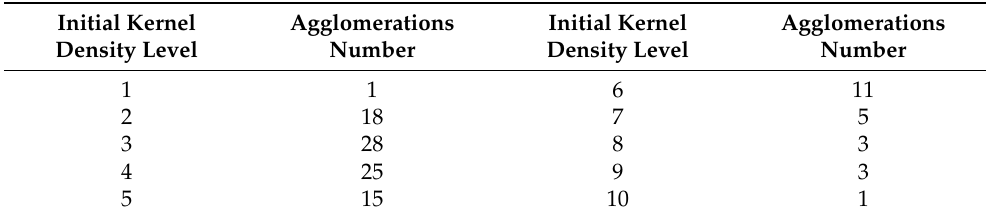
Table 4. Statistics regarding the number of agglomeration areas of different initial kernel density grades.